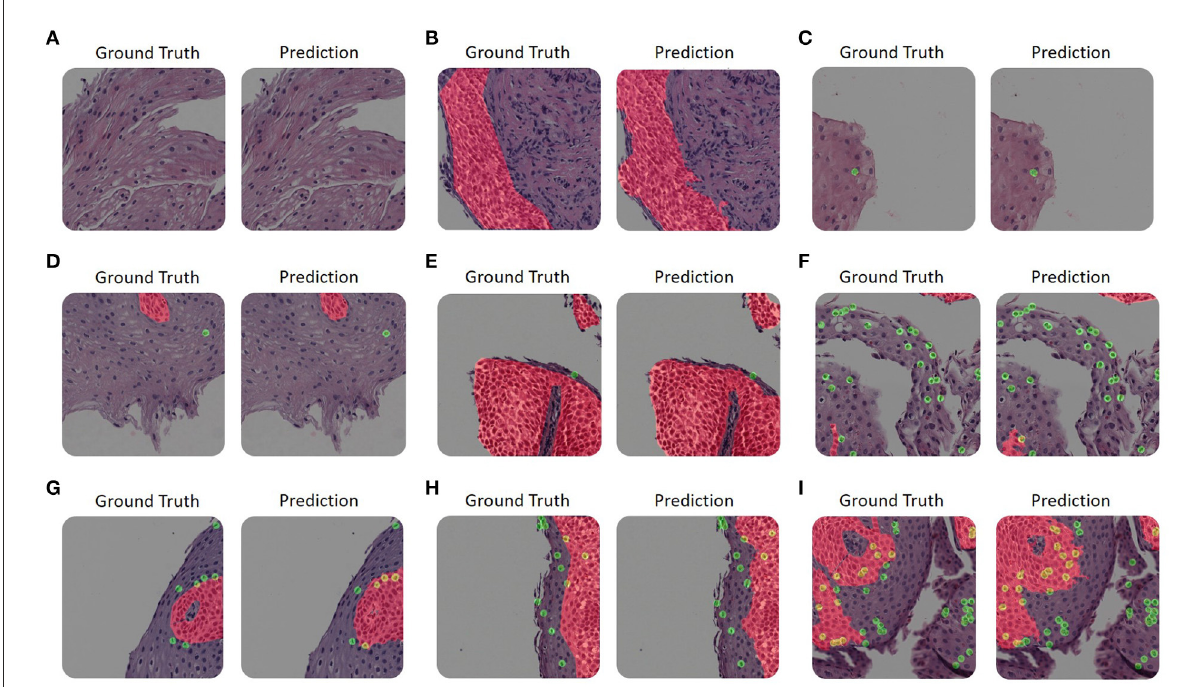
FIGURE2 Examples of our platform semantic segmentation. (A–I) The size of each image is 1200 × 1200 pixels. Each panel’s left-hand side is colored according to the ground truth as annotated by trained experts. The right-hand side is colored with its corresponding network prediction mask. Basal zone (BZ) pixels are colored with red, intact eosinophils (Eos-Intact) pixels are colored with green, and pixels associated with both (that is, eosinophils within a BZ area) are colored with yellow. (A–C) The upper row shows examples with only one label or none. (D) An example of an image that contains both a small number of basal cells and intact eosinophils. (E) An example of an image with a large basal zone and a small number of intact eosinophils. (F) An example that contains a small area of basal zone and a large number of intact eosinophils. (G–I) The bottom row displays examples with large basal zones and also a large number of intact